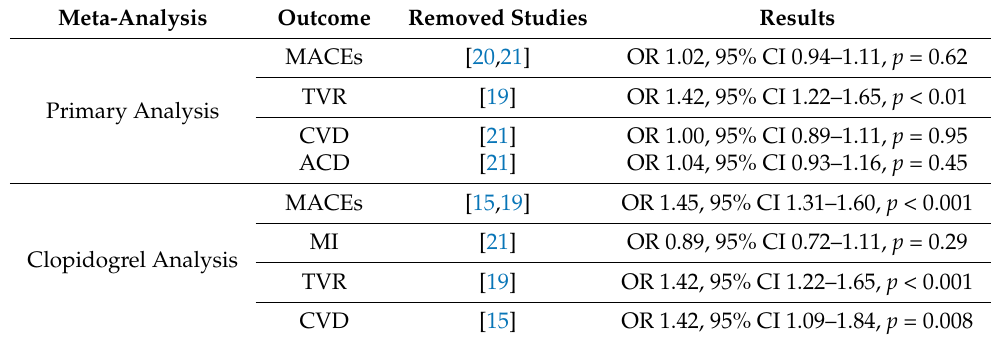
Table 3. Sensitivity analysis summary (I 2 = 0%).